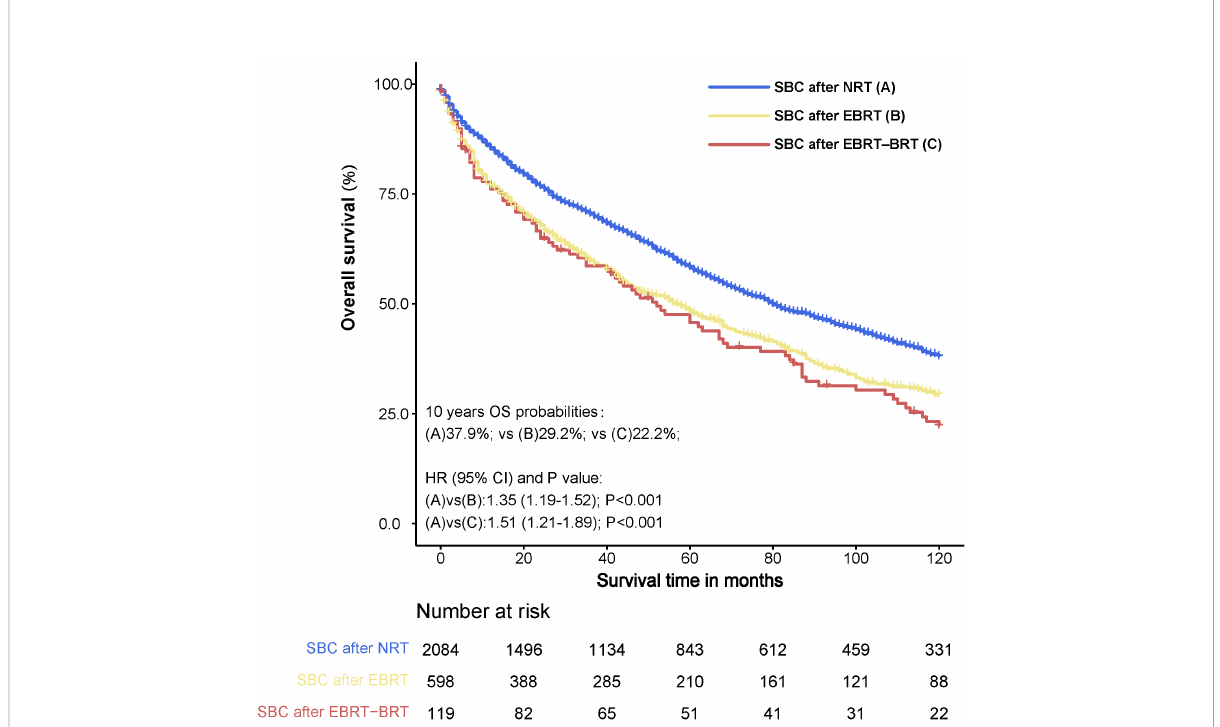
FIGURE 5 Survival comparison between primary pelvic cancer (PC) patients who developed secondary bladder cancer (SBC) after radiation therapy (RT) and no radiation therapy (NRT). Data. HRs were calculated using Cox regression. PC, pelvic cancers; SBC, secondary bladder cancer; HR, hazard ratio; CI, con fi dence interval; NRT, no radiation therapy; RT, radiation therapy; EBRT, external beam radiation therapy; EBRT – BRT, external beam radiation therapy with brachytherapy involving implants or isotopes.